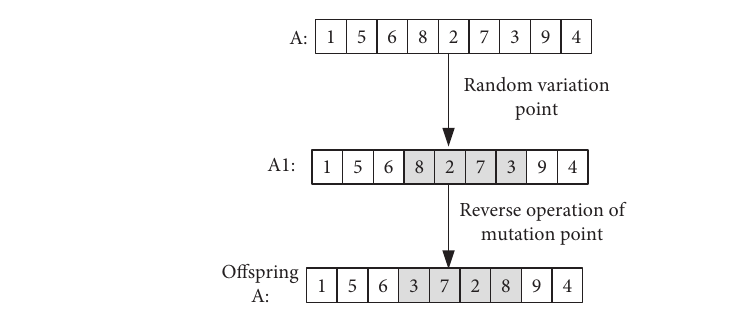
Figure 4: Mutation